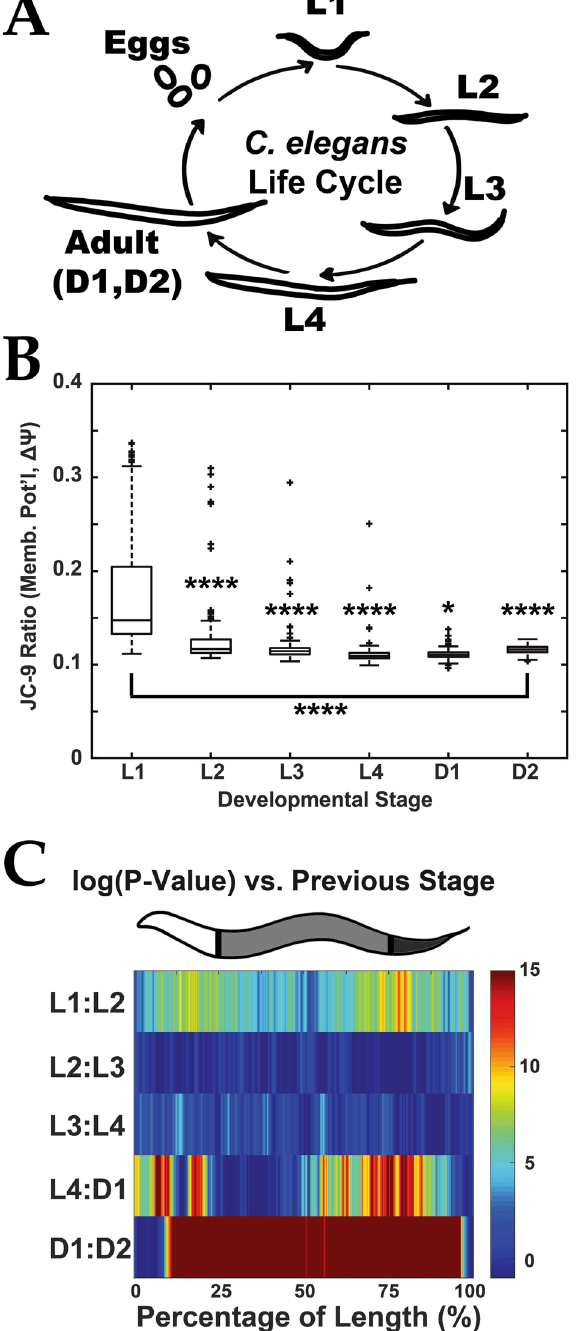
Figure 5. Mitochondrial membrane potential ( Δψ ) measurement during early C . elegans development. ( A ) Schematic of C . elegans life cycle to illustrate size and morphology differences. ( B ) Quantification of Δψ (by JC9–9 ratio) from live nematodes labeled with JC-9 at various stages of development. * P < 0.05, **** P < 0.00001. ( C ) Significance (log( P-value )) plots derived from median profiles in Figure S5H comparing each profile to its previous stage (e.g. L1–L2). For significance plots a value ≥ 0 is equivalent to P ≤ 0.05 by Wilcoxon Rank Sum Test. Plots are representative of three biological replicates and derived from n ≥ 50 organisms. Sample size ( n ) for all experiments and exact P-values can be found in the Supplementary Table. L.A. Daniele provided the illustrations for Part A originally published in: Daniele, J. R., Heydari, K., Arriaga, E. A. & Dillin, A. Identification and Characterization of Mitochondrial Subtypes in Caenorhabditis elegans via Analysis of Individual Mitochondria by Flow Cytometry. Anal . Chem . 88 , 6309–6316 (2016) 11